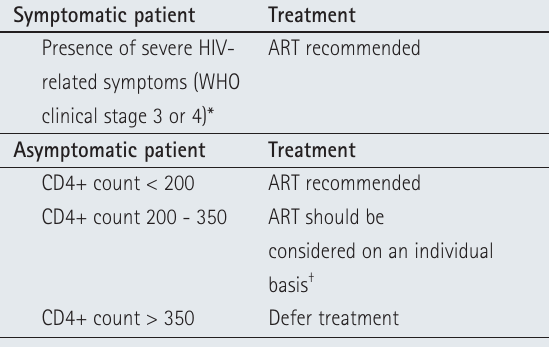
TABLE VI. INDICATIONS FOR STARTING ART